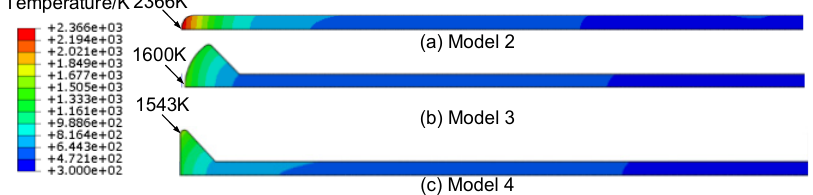
Figure 14. Comparison of the structural temperature field of the spike at 20 s. Table 9. Evolution of the drag coefficient.